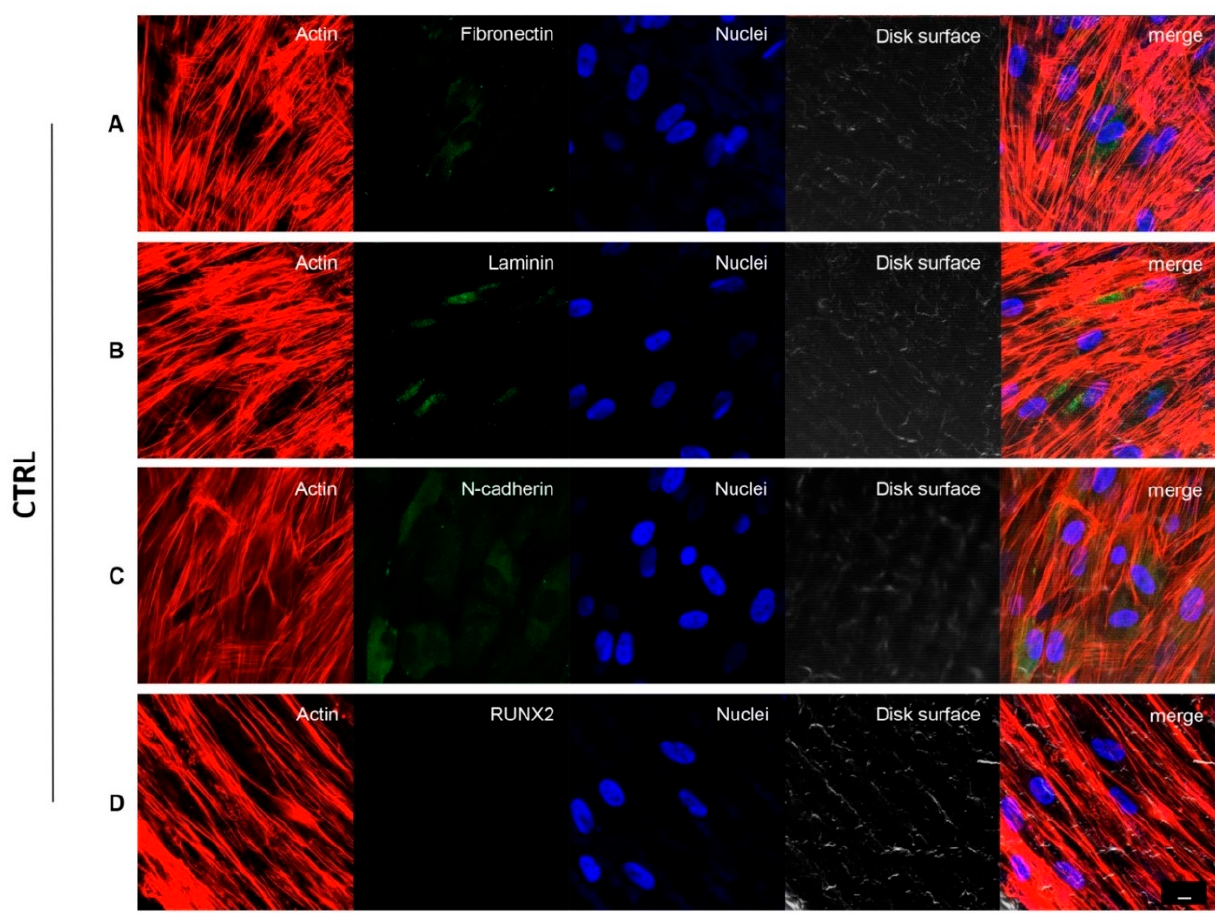
Figure 3. hPDLSCs cultured on CTRL titanium implant surface observed after 8 weeks. Cytoskeleton actin was stained in red fluorescence; specific markers:Fibronectin ( A ), Laminin ( B ), N-cadherin ( C ) and RUNX2 ( D ) were stained in green fluorescence; nuclei were stained in blue fluorescence. Scale bar: 10 μ m.